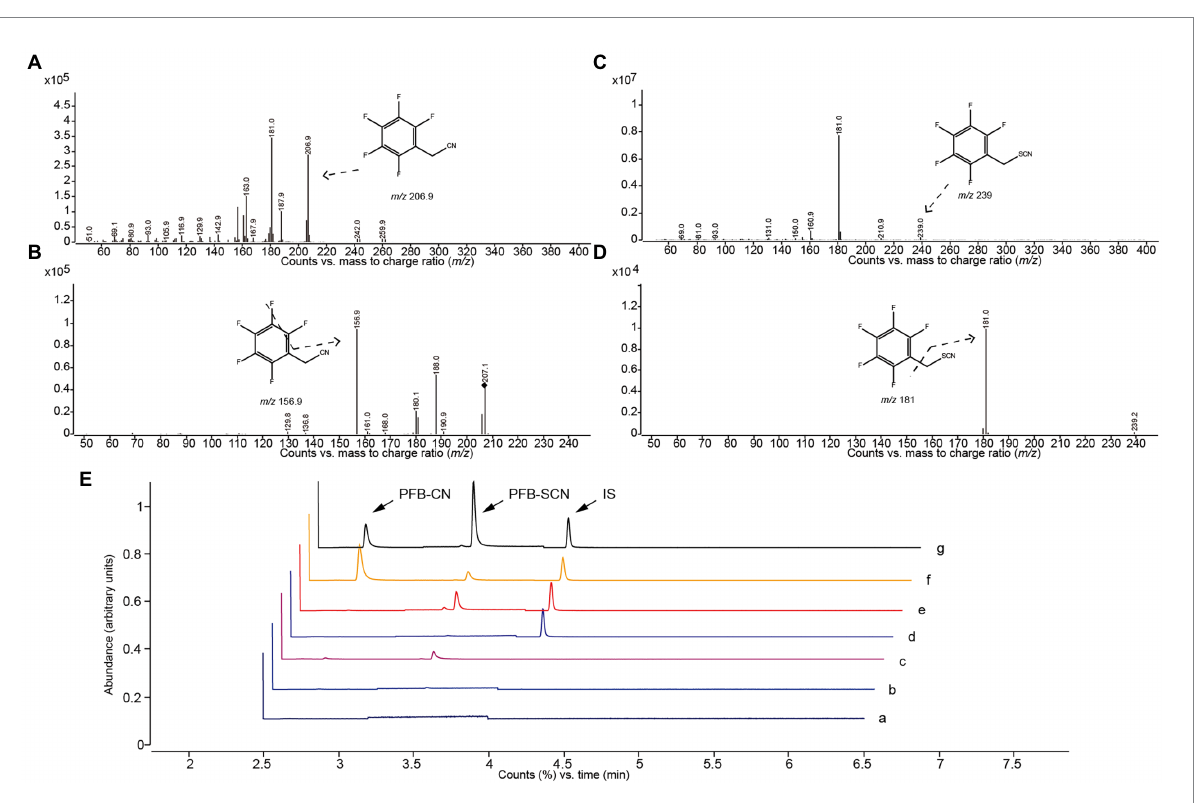
FIGURE 3 Mass spectrogram and chromatographs of alkylated CN and SCN. Abundance of (A) parent ions and (B) daughter ions of PFB-CN; Abundance of (C) parent ions and (D) daughter ions of PFB-SCN. GC–MS/MS chromatographs (E) of PFB-CN in (a) solvent, (b) non-spiked intestinal microbial enzyme solution, (c) non-spiked plasma, (d) is-spiked intestinal microbial enzyme solution, (e) is-spiked plasma, (f) intestinal microbial incubation sample, and (g) plasma sample.